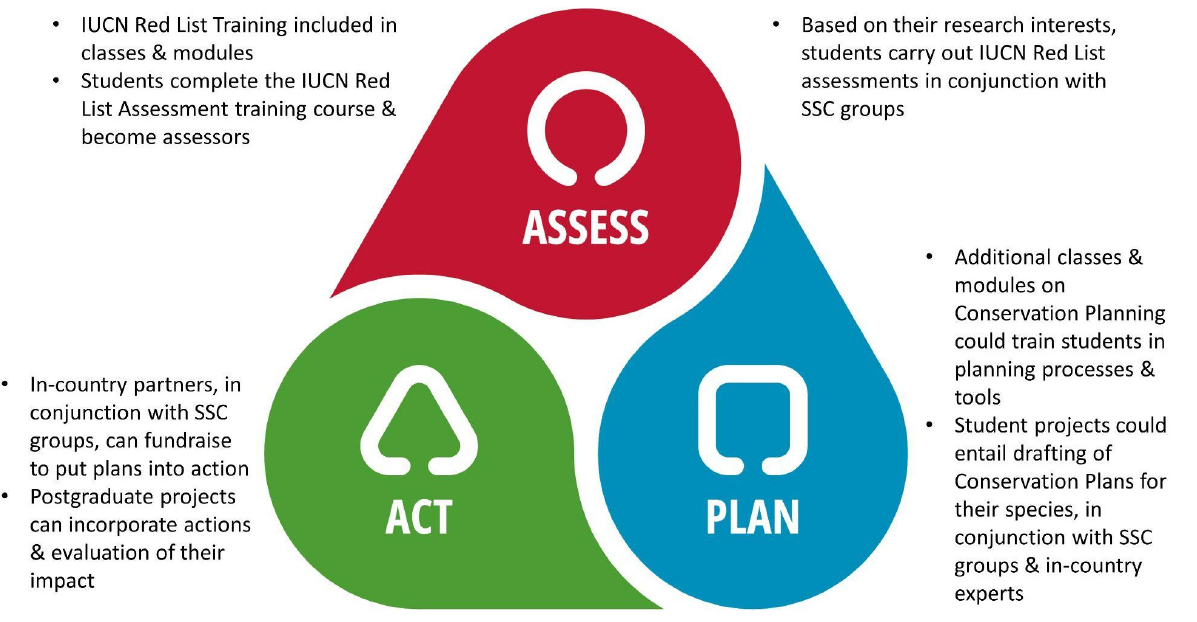
Figure 1. The IUCN Species Survival Commission’s Species Conservation Cycle and how students and academic classes can feed into the process.